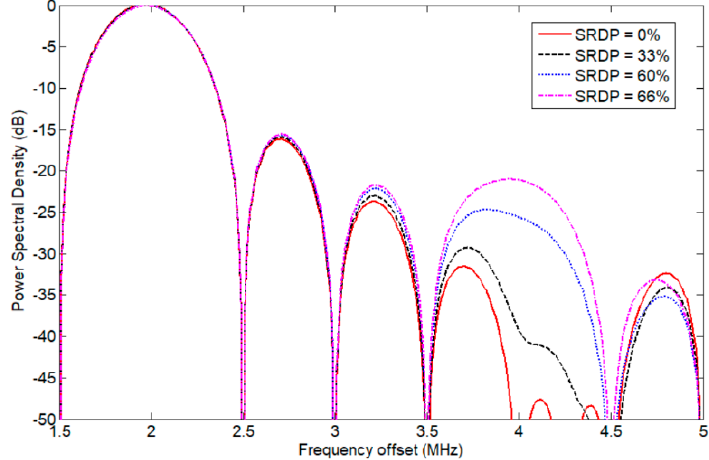
Figure 3. The frequency spectra of the bipolar pulse waveforms with different SRDP.